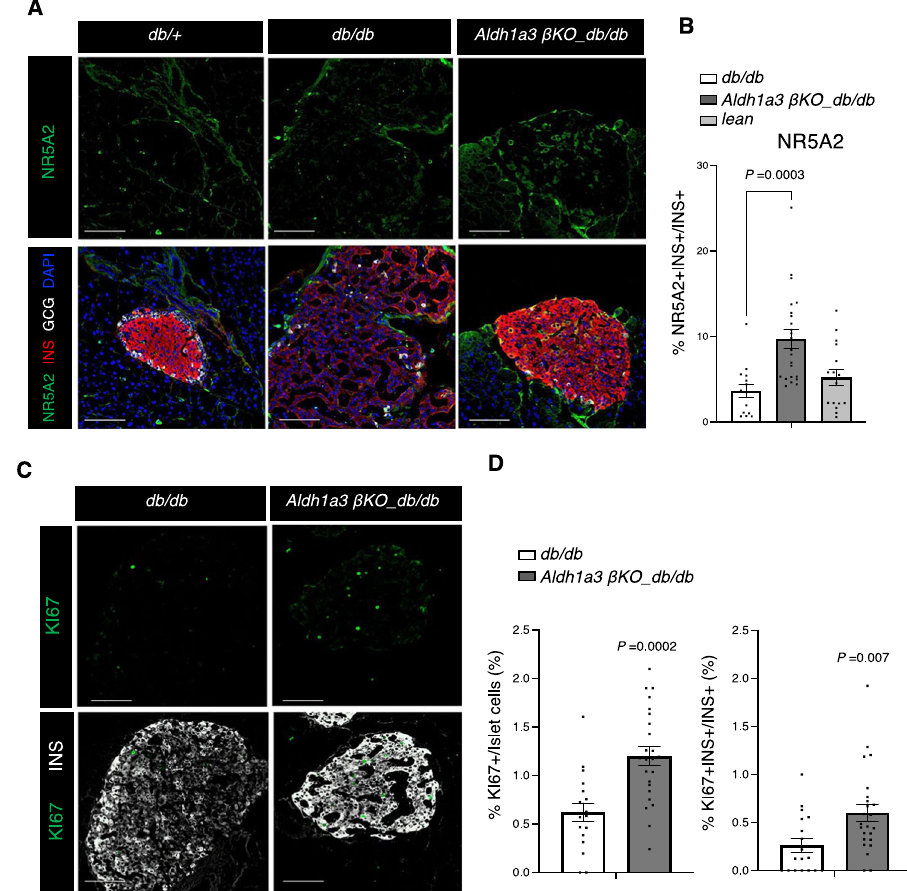
Fig. 6 | β -cell proliferation in β -Aldh1a3 KO_db/db . A Co-immunostaining of NR5A2 (green), insulin (Red), GCG (White) and DAPI (blue) in db/+ (left), db/db (middle), or β -Aldh1a3 KO_ db/db (right) pancreata. Scale bars: 100 μ M. B Ratio of NR5A2-positive cells in INS+/GCG- β -cells. All data are expressed as means±SEM. N =14,23or16 islets from 4 biologically independent samples per group. One-way ANOVA with multiple comparison test was used for statistical analysis. C Co-